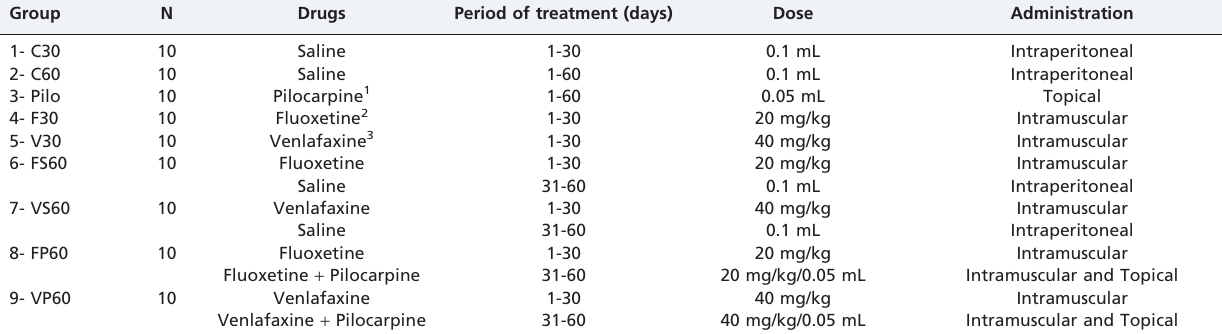
Table 1 - Control and experimental groups according to the drugs